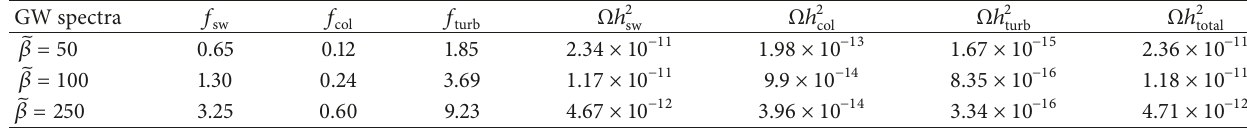
Table 3: The spectra of gravitational wave as predicted by our model. The emitted GW are within the reach of eLISA C1. GW